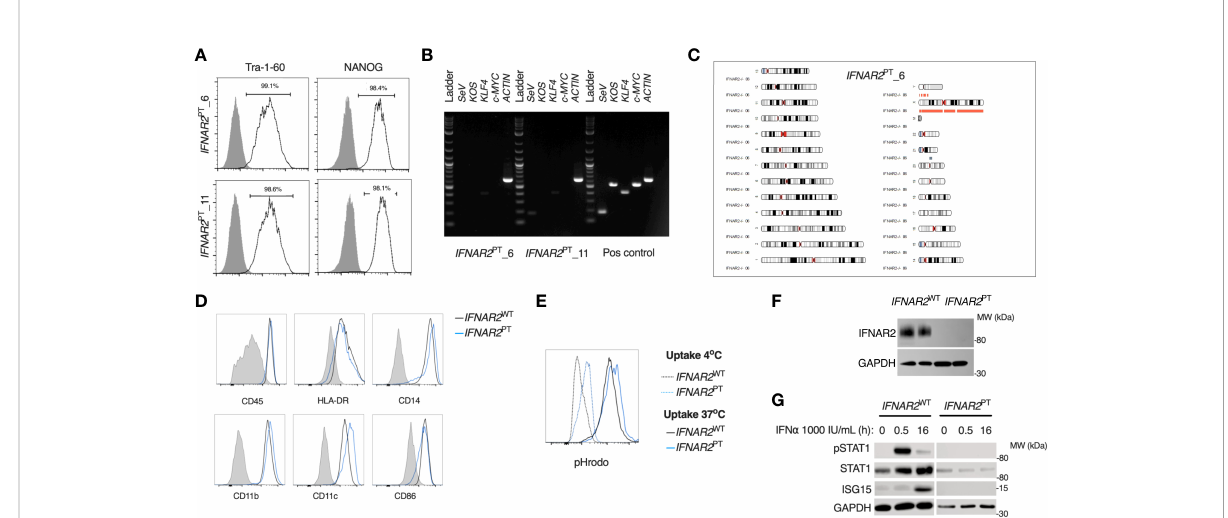
FIGURE 1 A model of IFNAR2 de fi cient human iPS-macrophages ( IFNAR2 PT iPS-M f ). (A) Expression of pluripotency markers by IFNAR2 PT iPSC clones 6 and 11 by fl ow cytometry. (B) PCR showing clearance of Sendai virus vector from IFNAR2 PT iPSC clones 6 and 11. (C) Karyogram produced from SNP array showing no gross abnormalities in the previously unpublished IFNAR2 PT iPSC clone 6. Red bars indicate loss or single copy, grey indicates loss of heterozygosity on chromosome 21 in the region of IFNAR2 (representative of data in IFNAR2 PT clone 11). (D) Expression of macrophage surface markers in IFNAR2 PT (clone 6) and IFNAR2 WT (WT1) iPS-M f by fl ow cytometry, representative of repeat experiments in IFNAR2 PT clone 11 and WT2. (E) Phagocytic uptake of Zymosan pHrodo particles in IFNAR2 PT (clone 6) and IFNAR2 WT (WT1) iPS-M f , representative of repeat experiments in clone 11 and WT2. (F) Immunoblot of IFNAR2 and GAPDH in IFNAR2 WT (WT2) and IFNAR2 PT (clone 11) iPS-M f , representative of repeat experiments in WT1 and clone 6. (G) Immunoblot of IFN-I signalling in IFN a 2b (1000 IU/mL) treated IFNAR2 PT (clone 11) and IFNAR2 WT (WT1) iPS-M f , representative of n = 3 independent